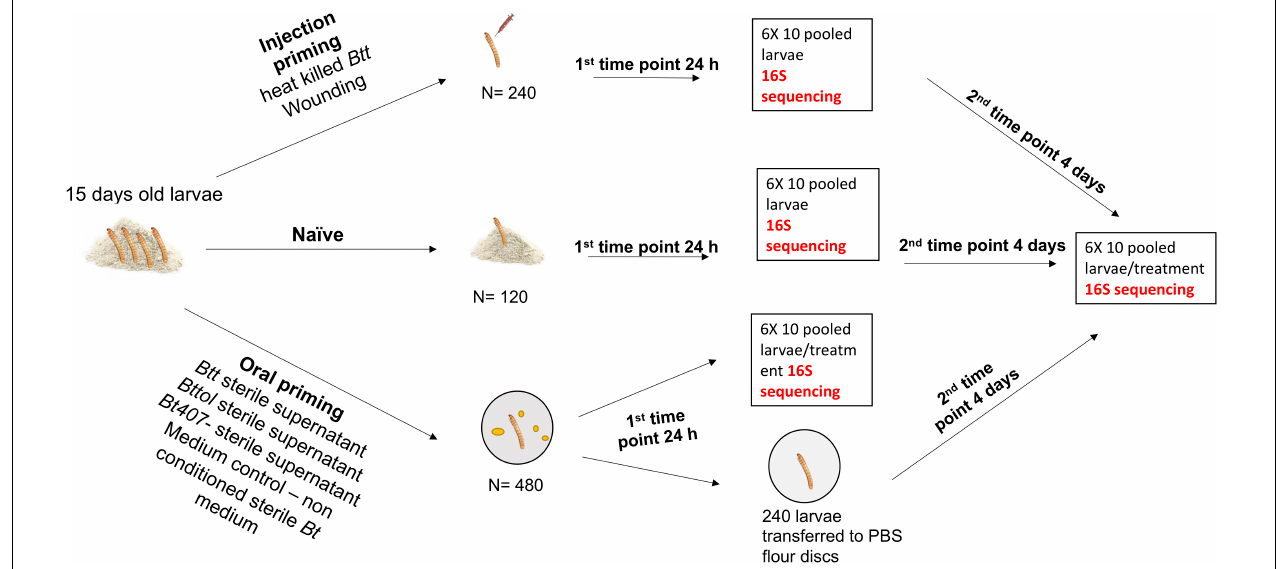
FIGURE 1 | Overview of the experimental design and sample preparation for